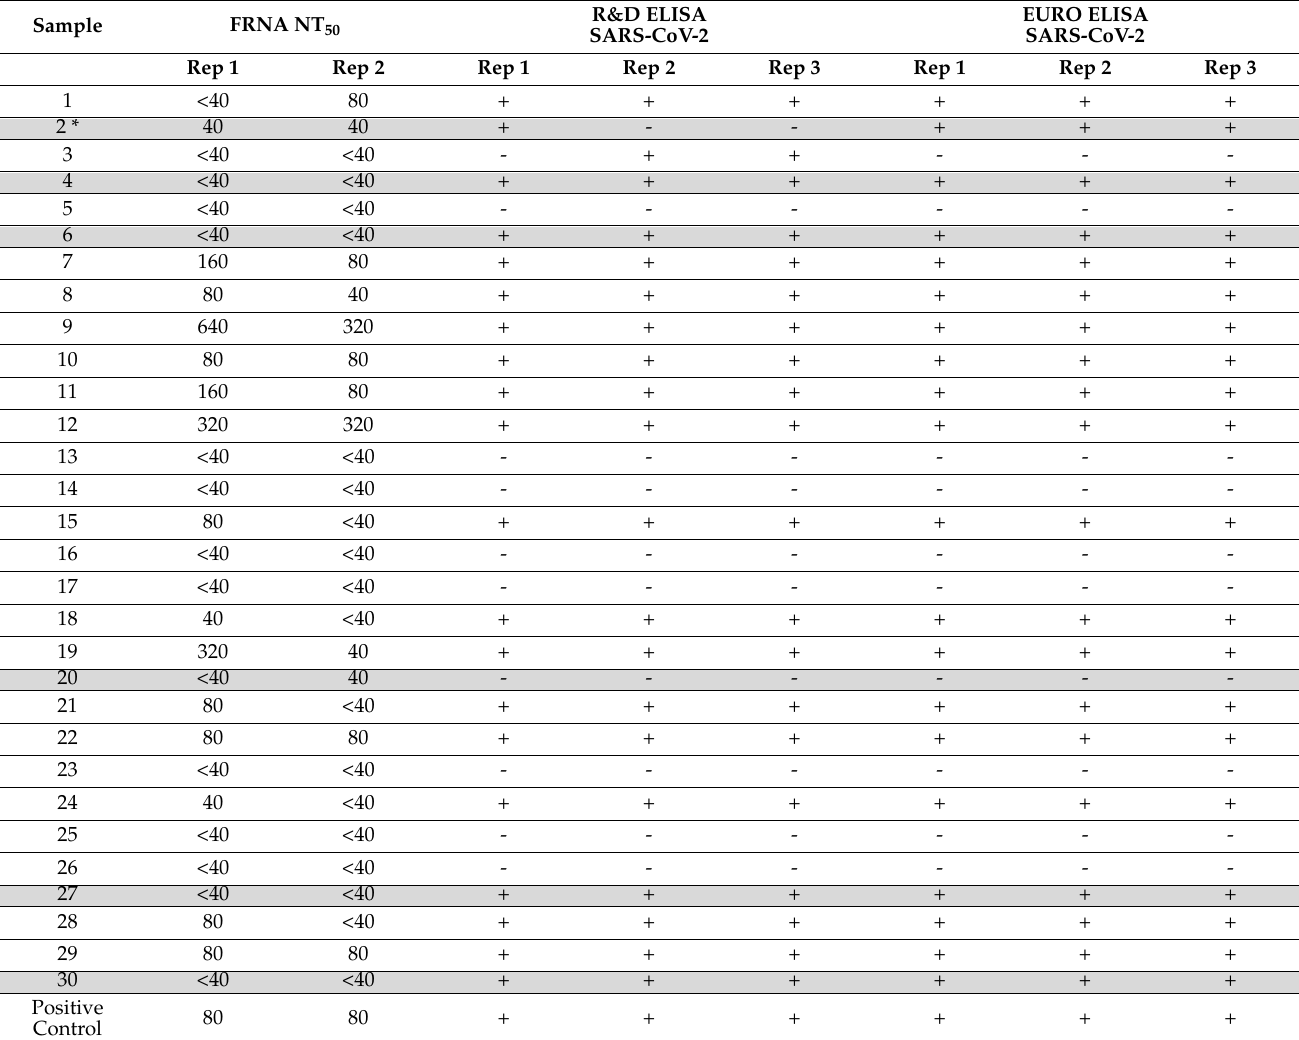
Table 7. Comparison of ELISA data to the FRNA NT 50